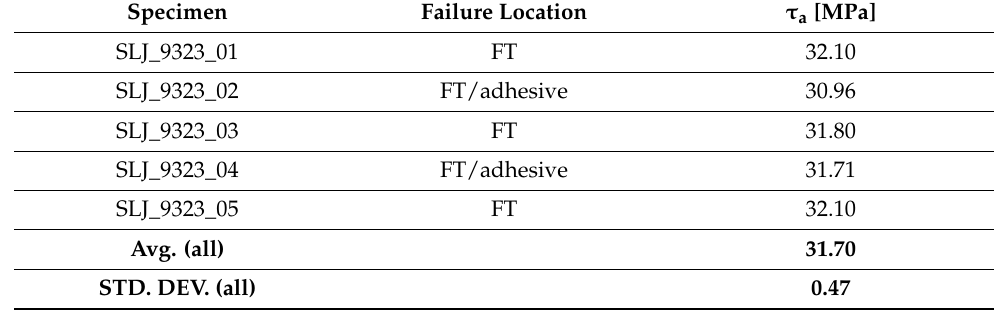
Table 4. Failure location and tensile strength of SLJ_9323 tests.